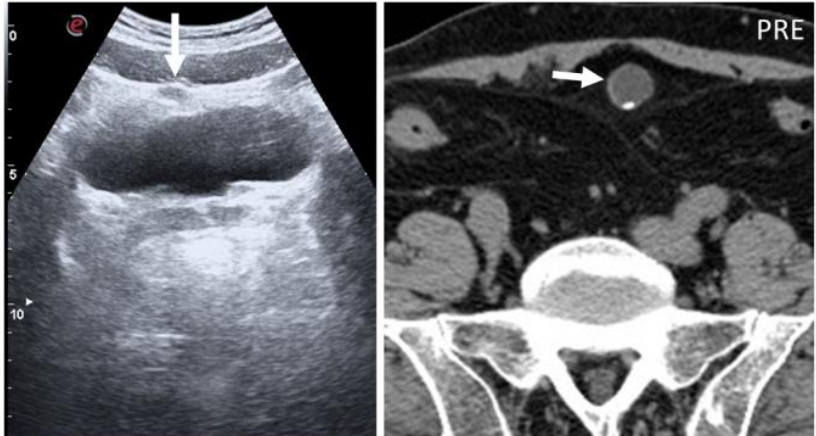
Figure 5. Urachal cysts are found along the superficial planes. On B-mode US, urachal anomalies appear as fluid-filled nodularity close to or in the context of the abdominal wall, incidentally found (arrow). As seen in axial, not-enhanced CT, small parietal calcification can also be seen (short arrow).